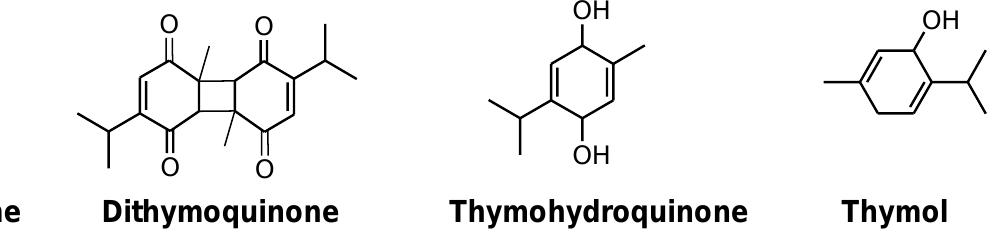
Figure 2. Chemical structures of major constituents of N. sativa .